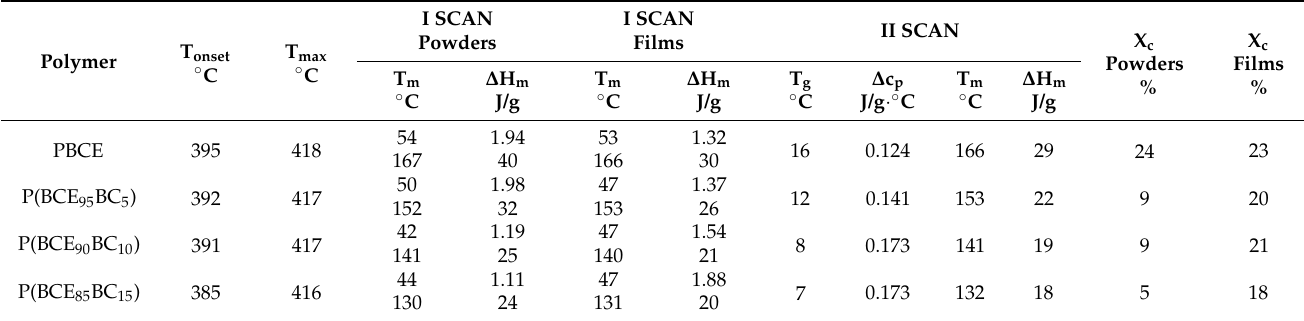
Figure 2. TGA traces of PBCE and P(BCE x BC y ) copolymers. Heating rate: 10 °C/min under N 2 flow. Table 2. Thermal (TGA and DSC) and structural (WAXS) characterization data of PBCE and P(BCE x BC y ) copolymers. Polymer T onset ◦